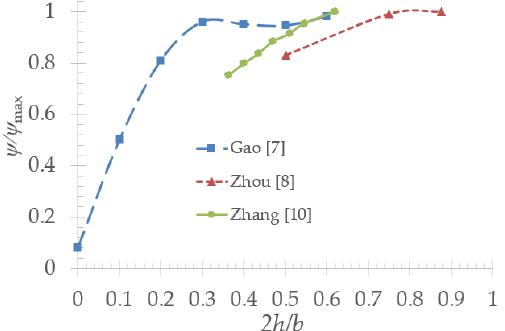
Figure 4. Tesla bladed pump lift head ratio versus coefficient h / b. (extracted from Gao [7], Zhou [8] and Zhang [10]).